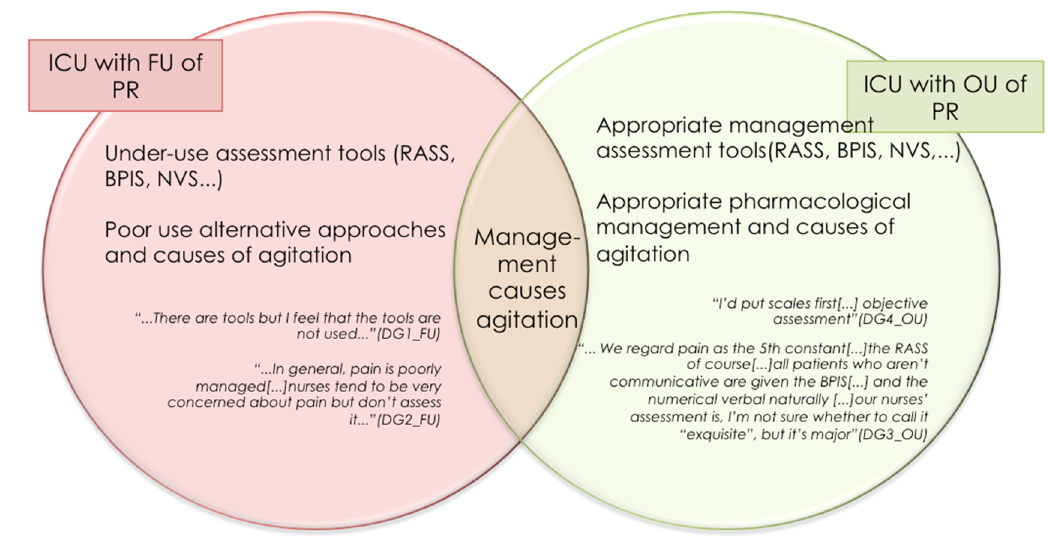
Figure 9. Venn diagram: under-use versus appropriate use of tools for assessment and management of the cause of agitation in units with frequent/systematic use of restraints versus units with occasional/individualized use of physical restraints. Abbreviations: BPIS: Behavioral Pain Indicator Scale; NVS: Numerical Verbal Scale; PR: physical restraint; RASS: Richmond Agitation Sedation Scale; ICU: intensive/critical care unit; OU: occasional/individualized use; FU: frequent/systematic use.